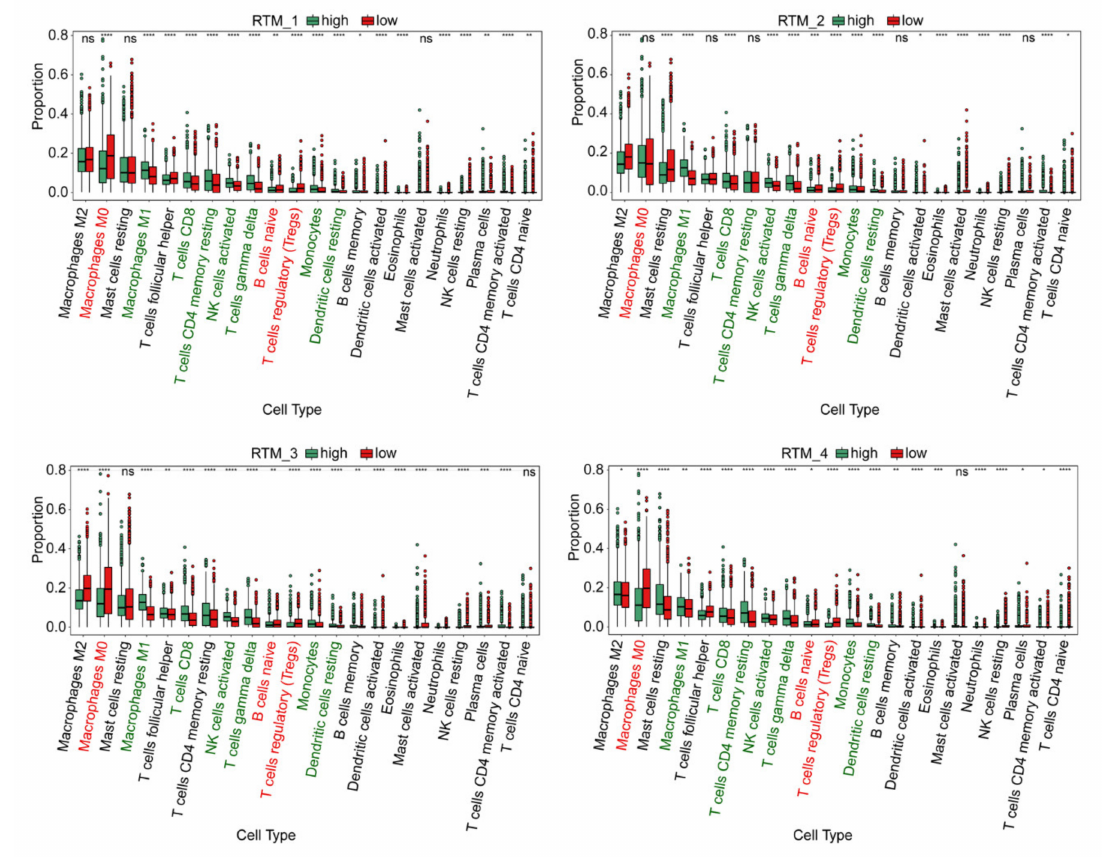
Figure 3. The immune characteristics of different subtypes of each RTM cluster. The proportions of immune cell clusters in different subgroups of each RTM cluster. The scattered dots represent the immune score of the two subgroups of each RTM cluster. The thick lines represent the median value. The bottom and top of the boxes are the 25 th and 75 th percentiles (interquartile range), respectively. M1 macrophages, CD8T cells, resting memory CD8T cells, activated NK cells, gamma delta T cells, monocytes and resting dendritic cells (green font) were more abundant in each RTM cluster-high subgroup, while M0 macrophages, naïve B cells and T regulatory cells (Tregs) (red font) were more abundant in each RTM cluster-low subgroup. Significant statistical differences between the two subgroups were assessed using the Wilcoxon test (ns: not significant, * p < 0.05, ** p < 0.01, *** p < 0.001, **** p <